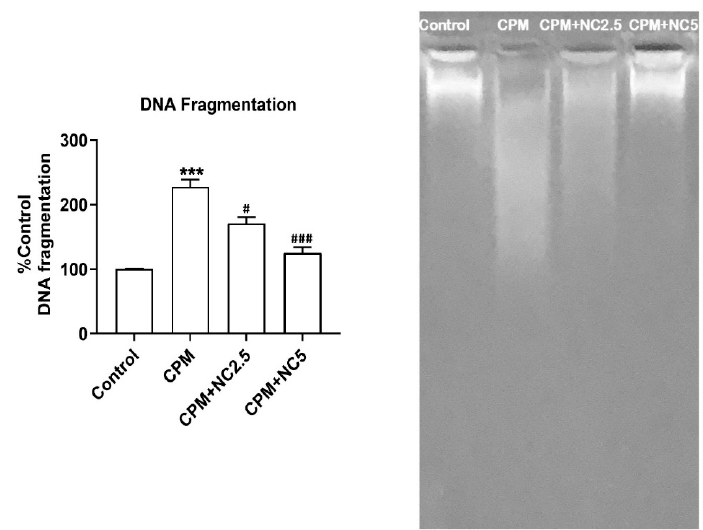
Figure 6. Administration of NC offers excellent protection against CPM-induced DNA fragmentation. Outcomes are presented as the mean ± SE (n = 4) of each group. *** p < 0.001 vs. control, # p < 0.05; ### p < 0.001 vs. CPM. NC shields DNA fragmentation as shown in lane-3 and lane-4 as allied to CPM (lane-2). However, CPM triggers DNA breaks in lane-2 as compared to control lane-1.